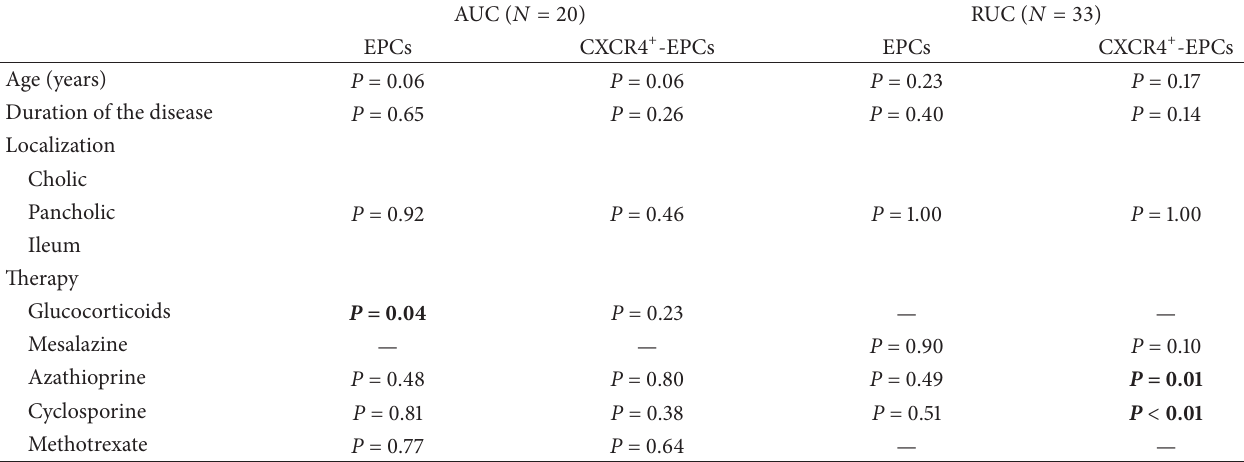
Table 2: Summary of 𝑃 values for multivariate analysis of variance statistics in AUC and RUC